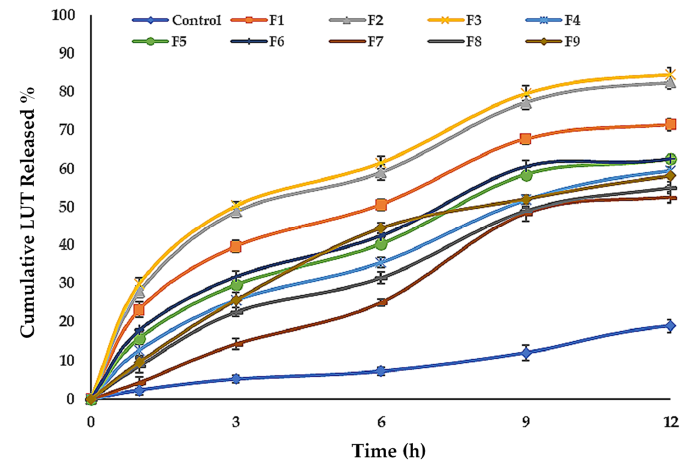
Figure 5. Cumulative percentage release of LUT from ethosomal formulations (mean ± SD, n = 3). Control was an aqueous suspension of the drug.